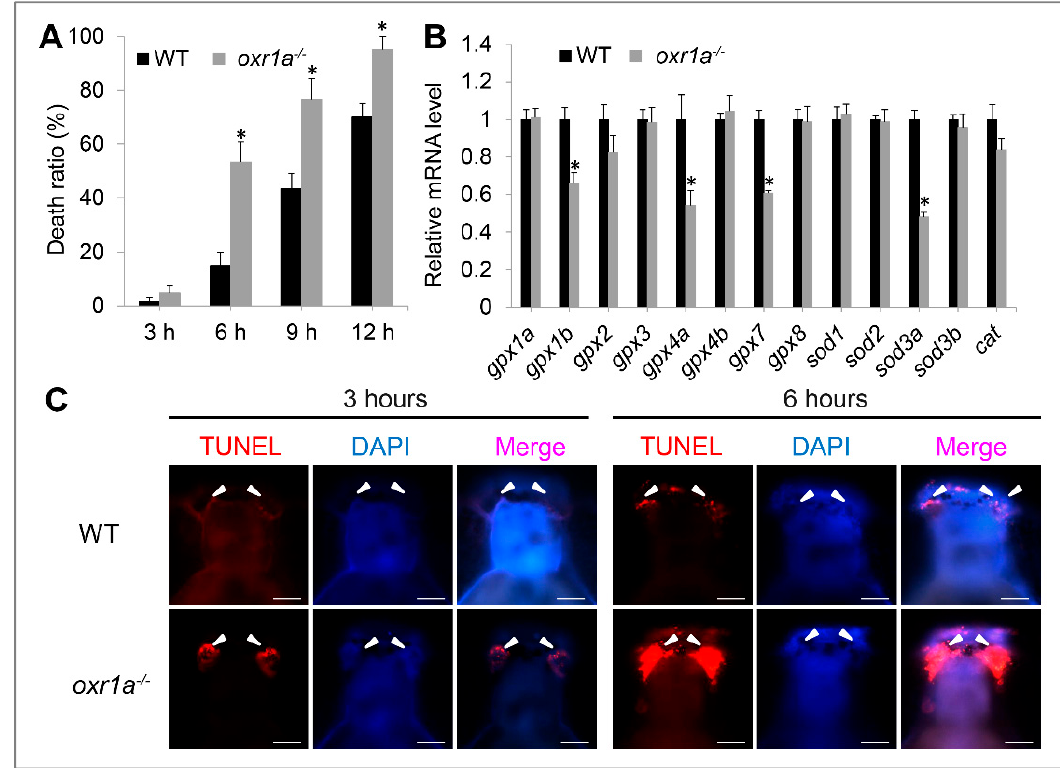
Figure 6. Oxr1a − / − mutant zebrafish are sensitive to oxidative stress. ( A ) WT and oxr1a − / − mutant larvae were exposed to 2 mM H 2 O 2 for 12 h, and the latter showed a higher death rate. ( B ) Oxr1a mutation inhibited the expression of antioxidant genes include gpx1b , gpx4a, gpx7 and sod3a . ( C ) Three and 6 h after H 2 O 2 stress, more apoptotic cells were observed in the olfactory bulbs of oxr1a − / − mutant larvae by TUNEL staining. The white arrowhead indicates the distribution of TUNEL-positive cells. Bars = 200 μ m. * indicates significant differences ( p < 0.05).